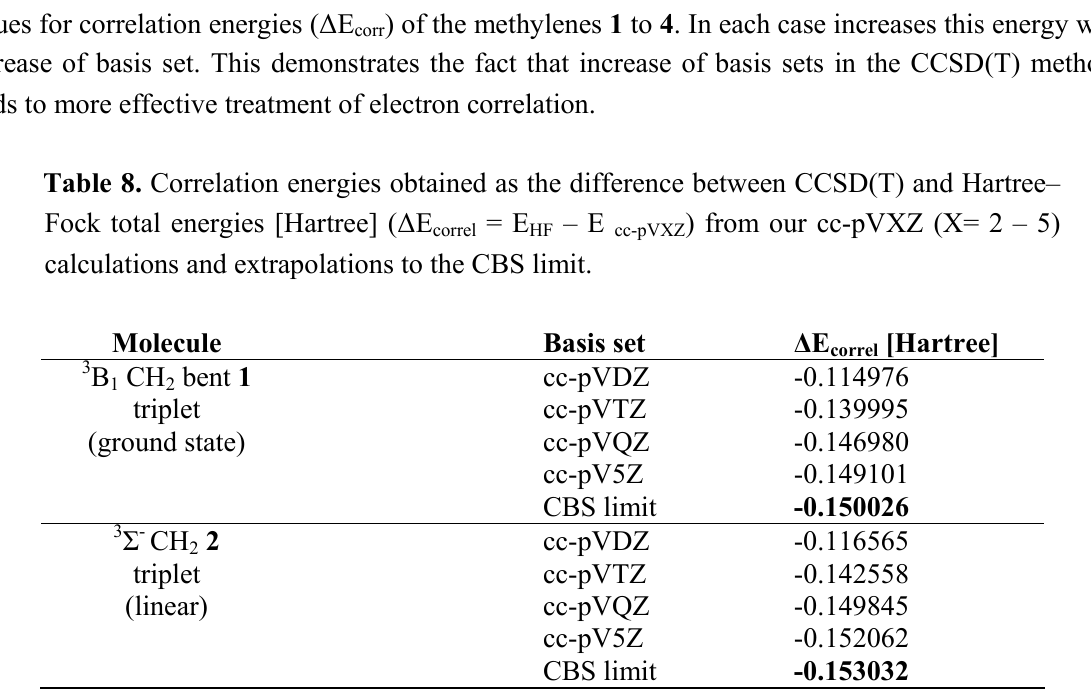
= E – E ) from our cc-pVXZ (X= 2 – 5) correl HF cc-pVXZ